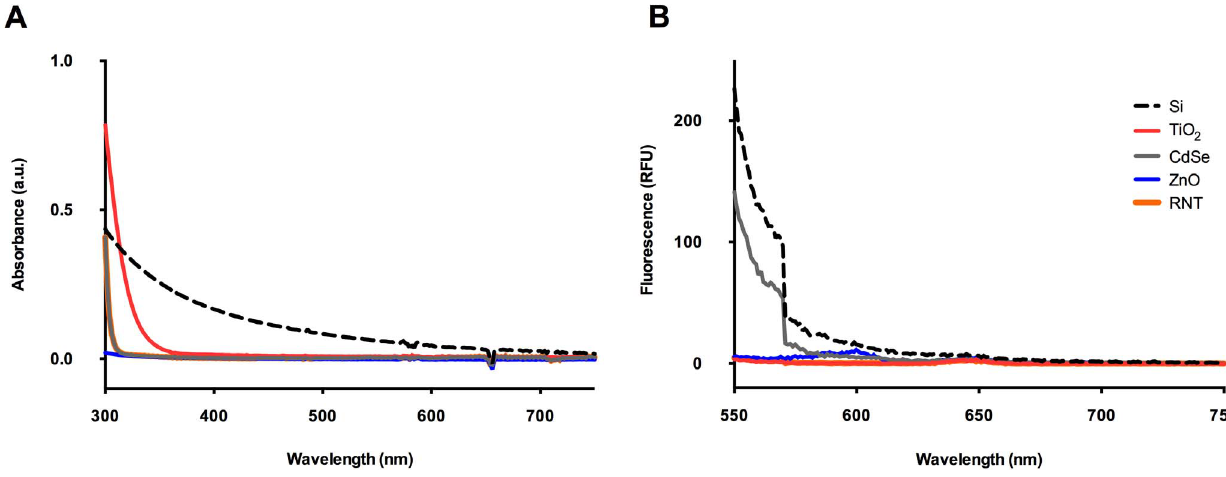
Figure 2. Spectroscopic measurement of optical characteristics of nanoparticles. (A) Absorbance of nanoparticles; (B) Fluorescence (RFU) of nanoparticles (excitation, 531